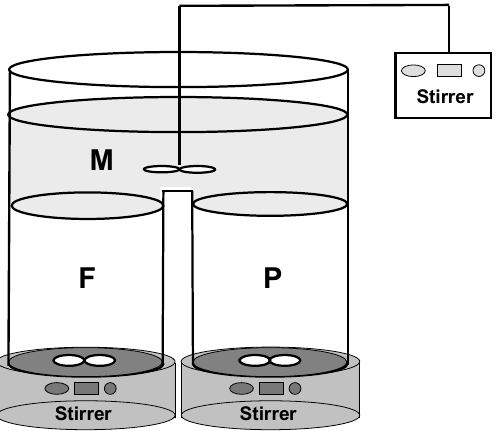
Figure 3. Schematic representation of the experimental cell (F: feed phase; M: membrane phase; P: product phase).